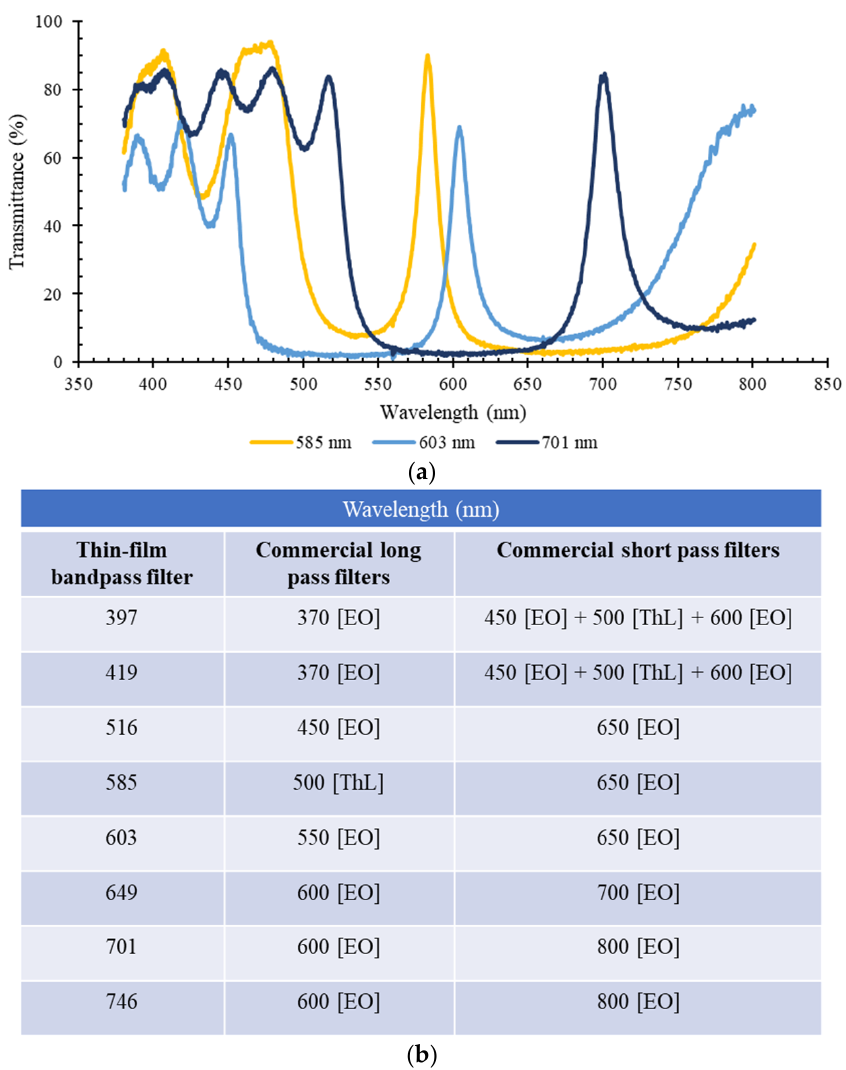
Figure 6. ( a ) Experimental results ( n = 3) of transmittance (%) vs. wavelength (nm), using a spectro- photometric top bench setup for 3 of the SiO 2 /TiO 2 optical filters centred at 585, 603 and 701 nm, without using commercial filters; ( b ) list of the commercial long pass and short pass optical filters and respective manufacturers (EO–Edmund Optics; ThL-Thorlabs) used in combination with each of the 8 bandpass thin-film optical filters (see Figure S2 of the Supplementary Material for the optical transmittance spectra of these filters).